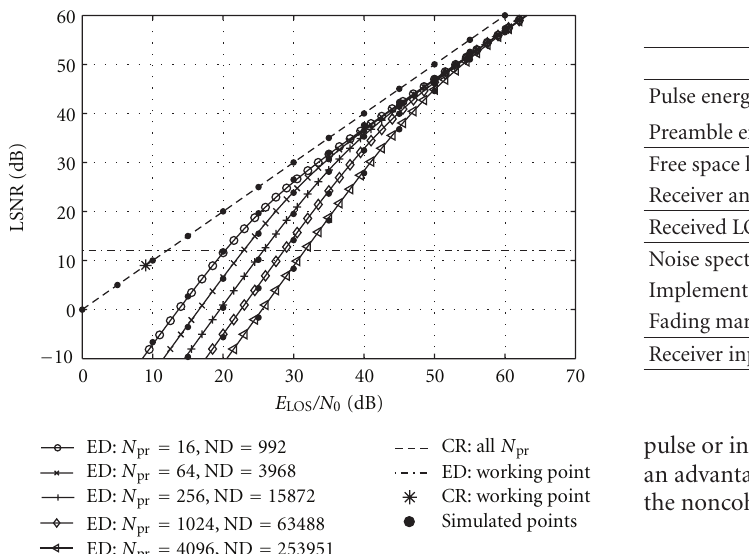
Figure 3: Relation between input SNR ( E LOS /N 0 ) and output SNR (LSNR) with respect to the noise dimensionality ND = N s N pr T I W RRC for the energy detector (ED) and the coherent receiver (CR). The fixed parameters are N s = 31, T I = 2 . 0032ns, and W RRC = 1GHz.